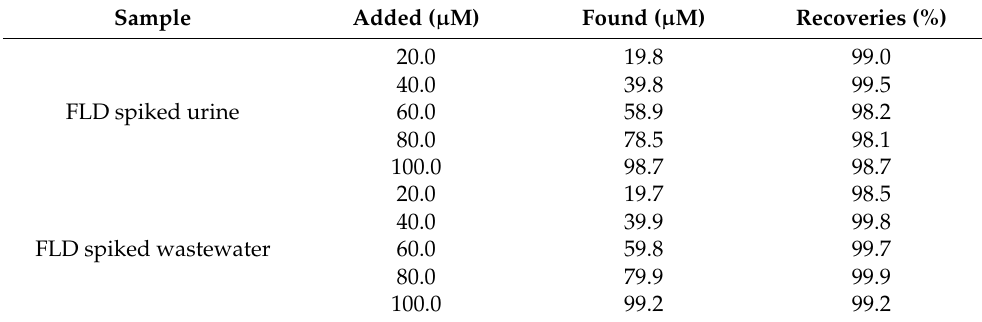
Figure 8. Real sample analysis in ( A ) human urine samples and ( B ) wastewater samples using SrMnO 3 / f- BN composite modified SPCE electrode. Table 2. Practicality of FLD detection in spiked human urine and wastewater samples ( n =